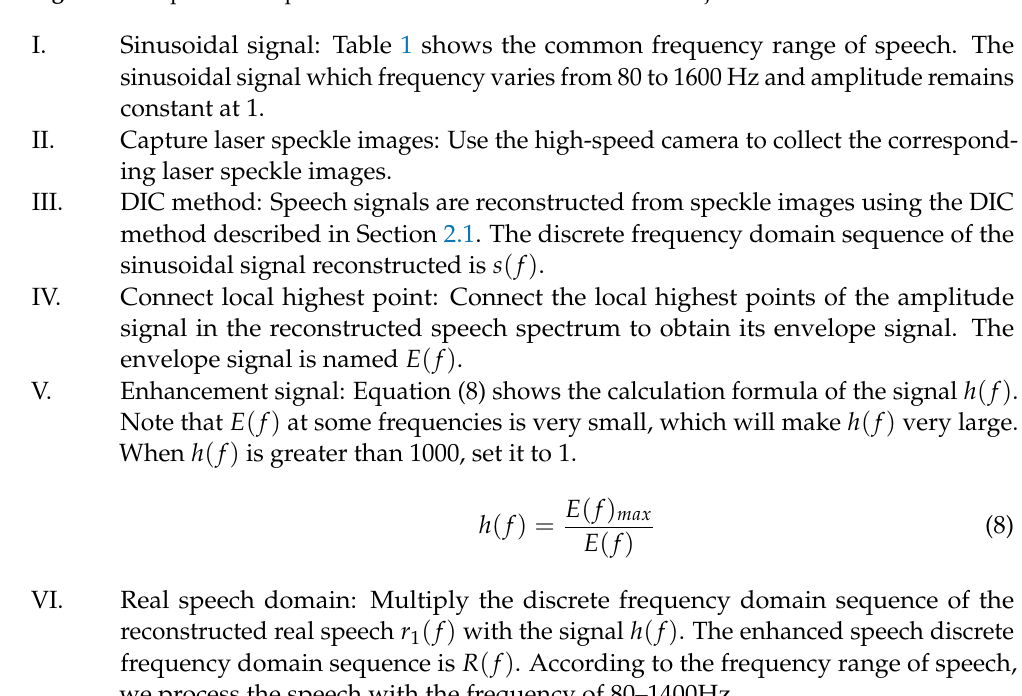
Figure 7. The process of speech enhancement when the vibration object is a carton.